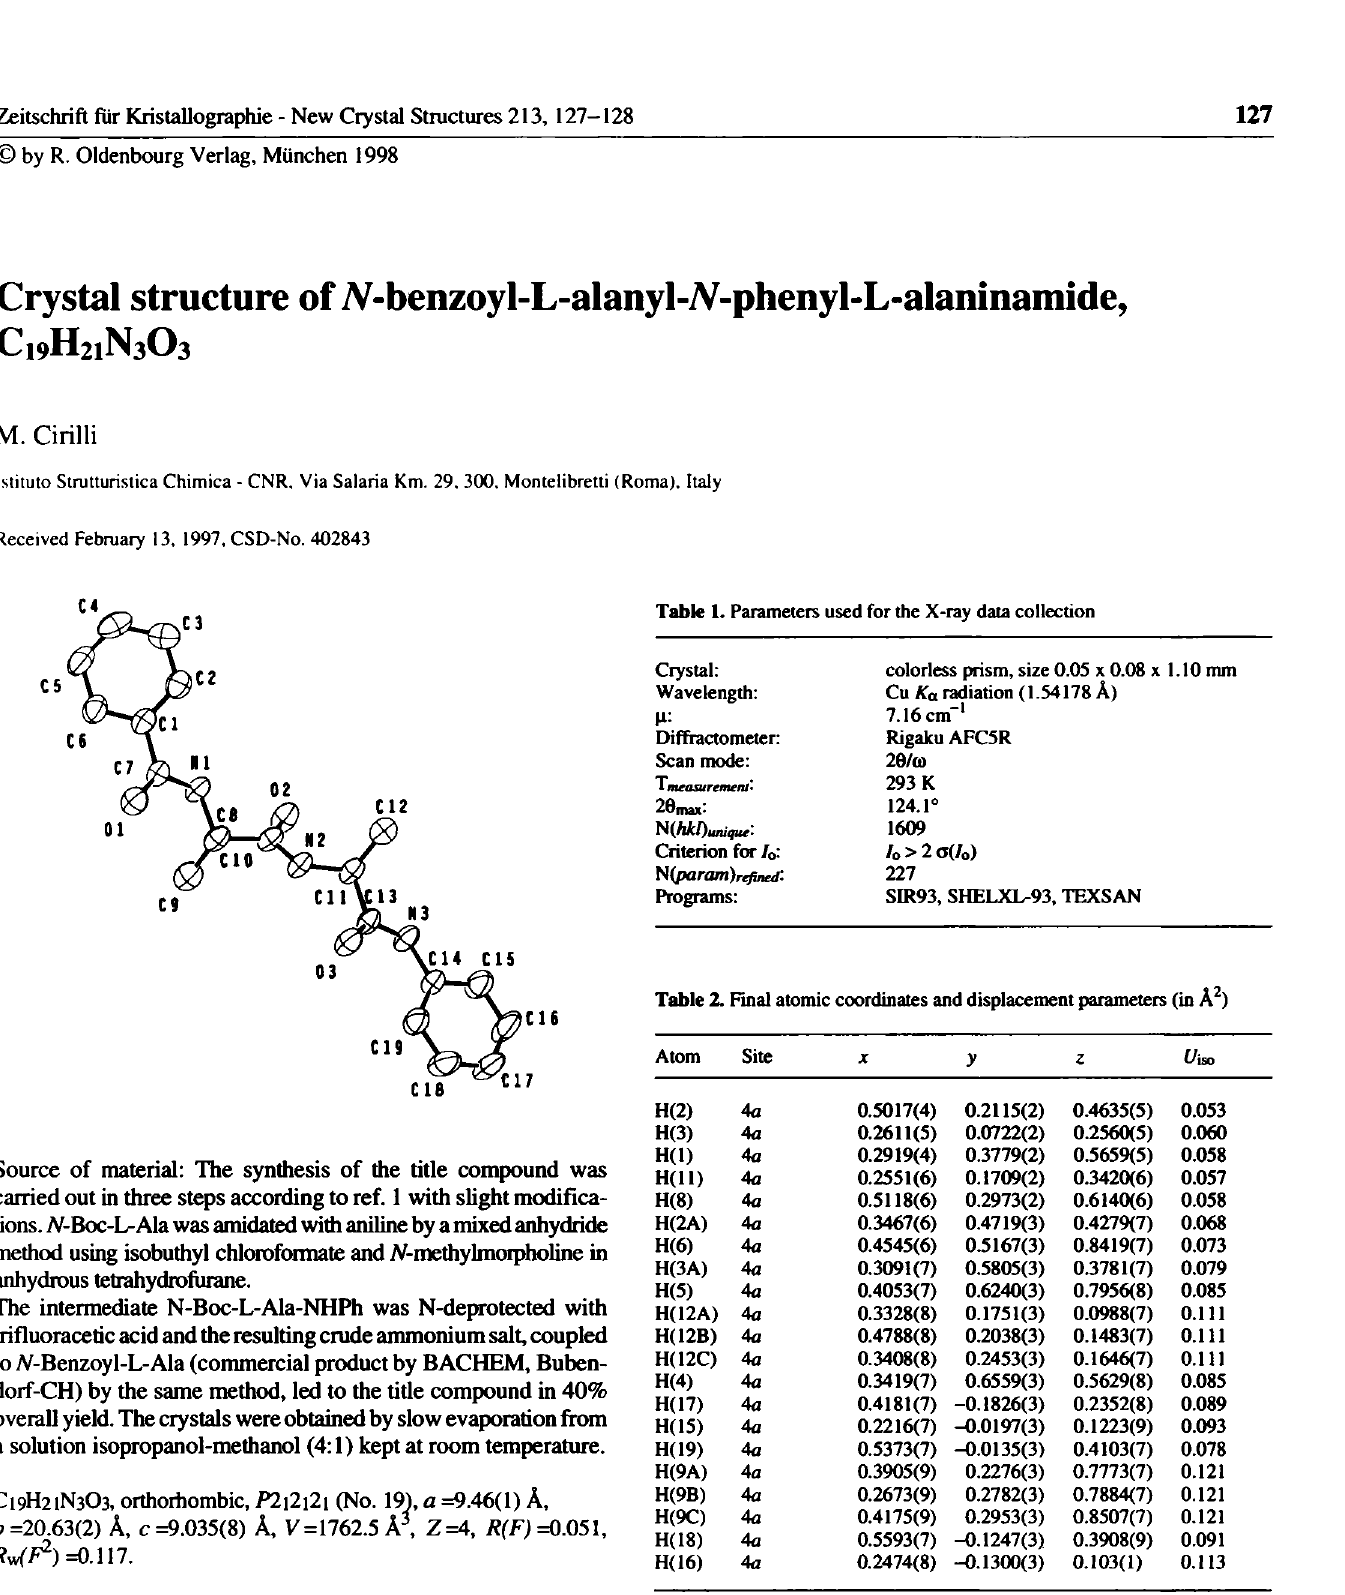
Table 3. Final atomic coordinates and displacement parameters (in Â^)